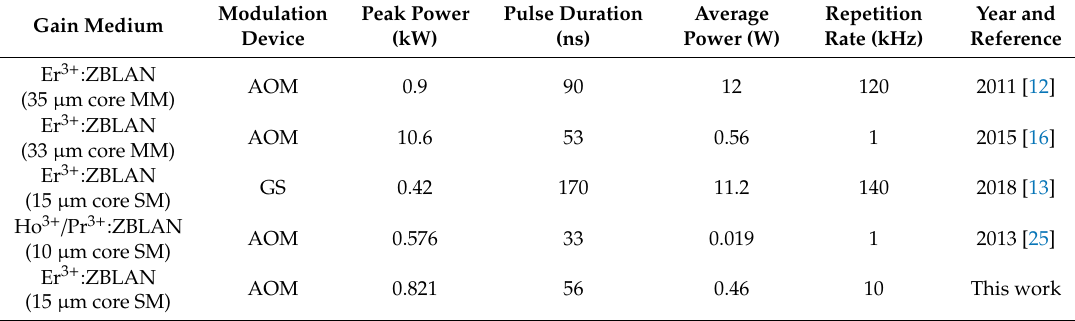
Table 1. Progress of actively Q-switched and gain-switched 3 µm fiber lasers (AOM: acousto-optic modulator; GS: gain-switched; MM: multi-transverse mode; SM: single-transverse mode; and ZBLAN